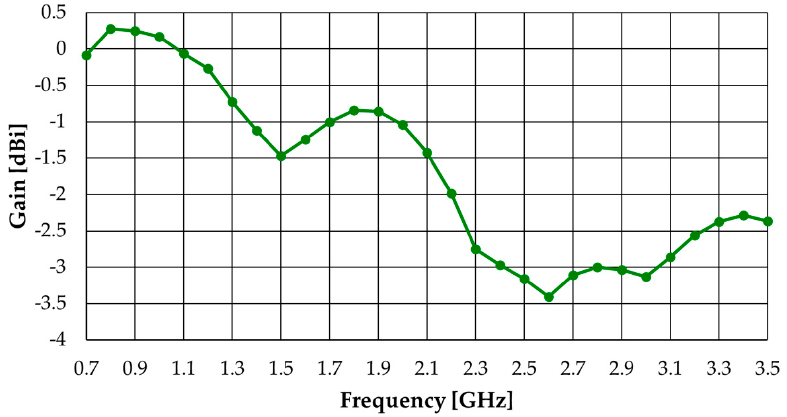
Figure 20. Simulated realized gain results of the modified octagonal monopole with absorber and metal shield.